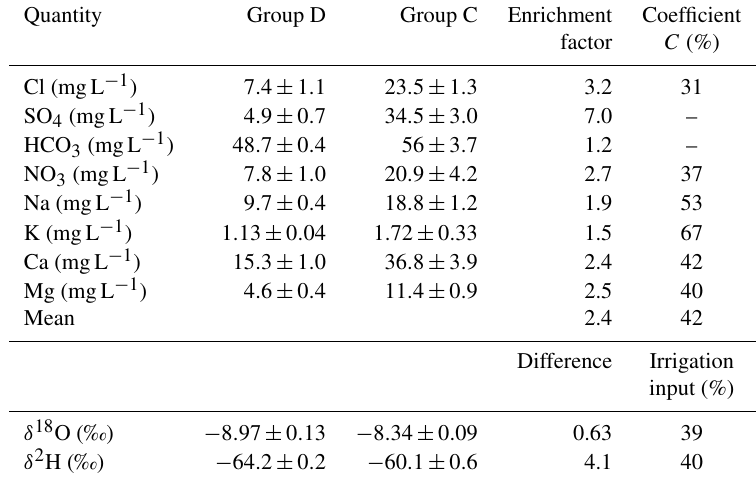
Table 4. Average chemical and isotopic concentrations of Group C and Group D. Enrichment factors and IRF coefficients ( C ) for the chemicals and isotopic differences and irrigation inputs for the isotopes are